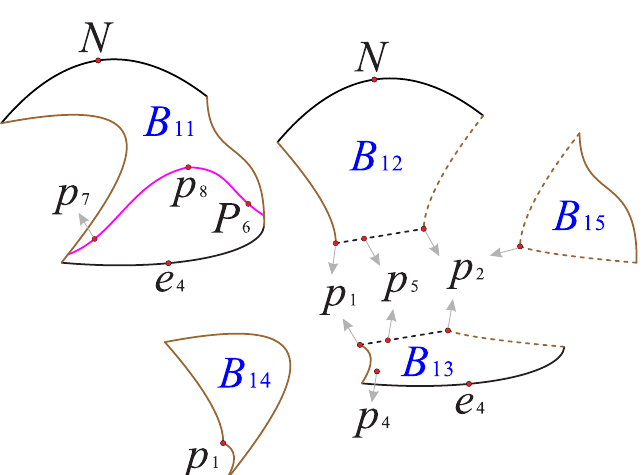
Figure 18. The three boundary surfaces and two boundary planes of the region R 1 .